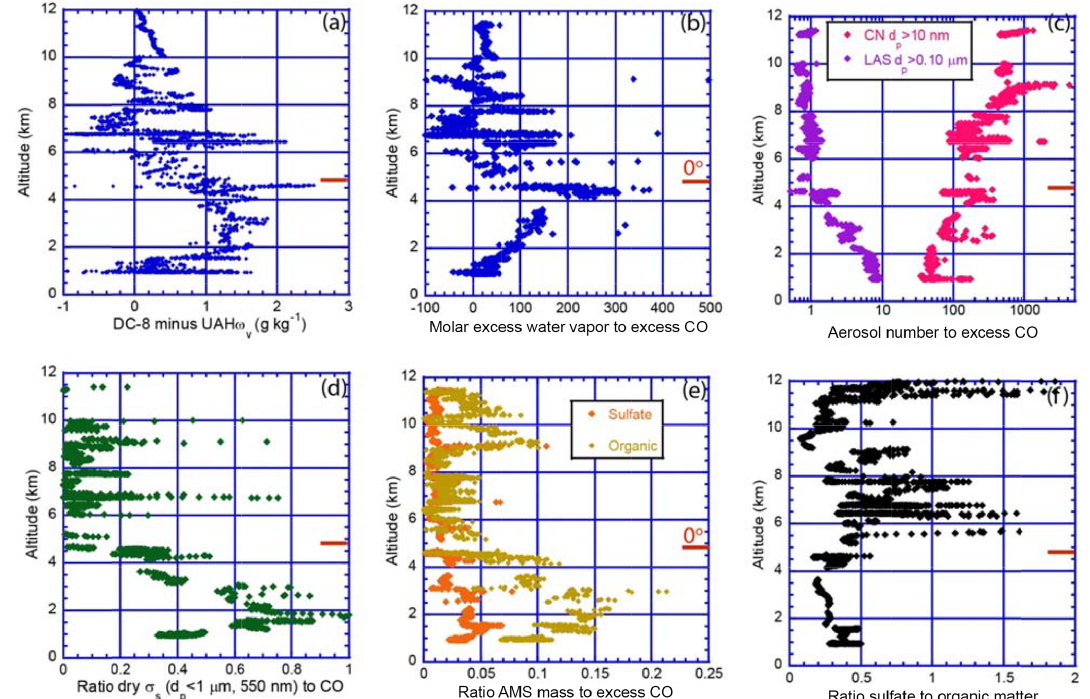
Figure 8. (a) Difference in water vapor mixing ratio between the DC-8 profile and the SEACONS 12 August 2013 radiosonde release at Huntsville, AL. Profiles of key constituents relative to excess CO including (b) excess water vapor to excess CO, (c) aerosol number, (d) dry light scattering, (e) organic carbon and sulfate to excess CO, and (f) ratio of sulfate to particulate organic